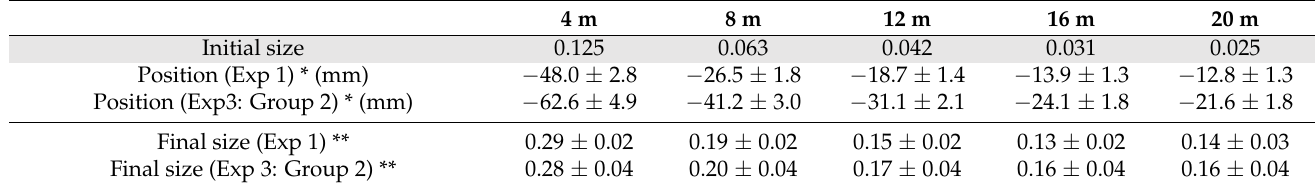
Table 1. Average Initial and Final Sizes/Positions for All